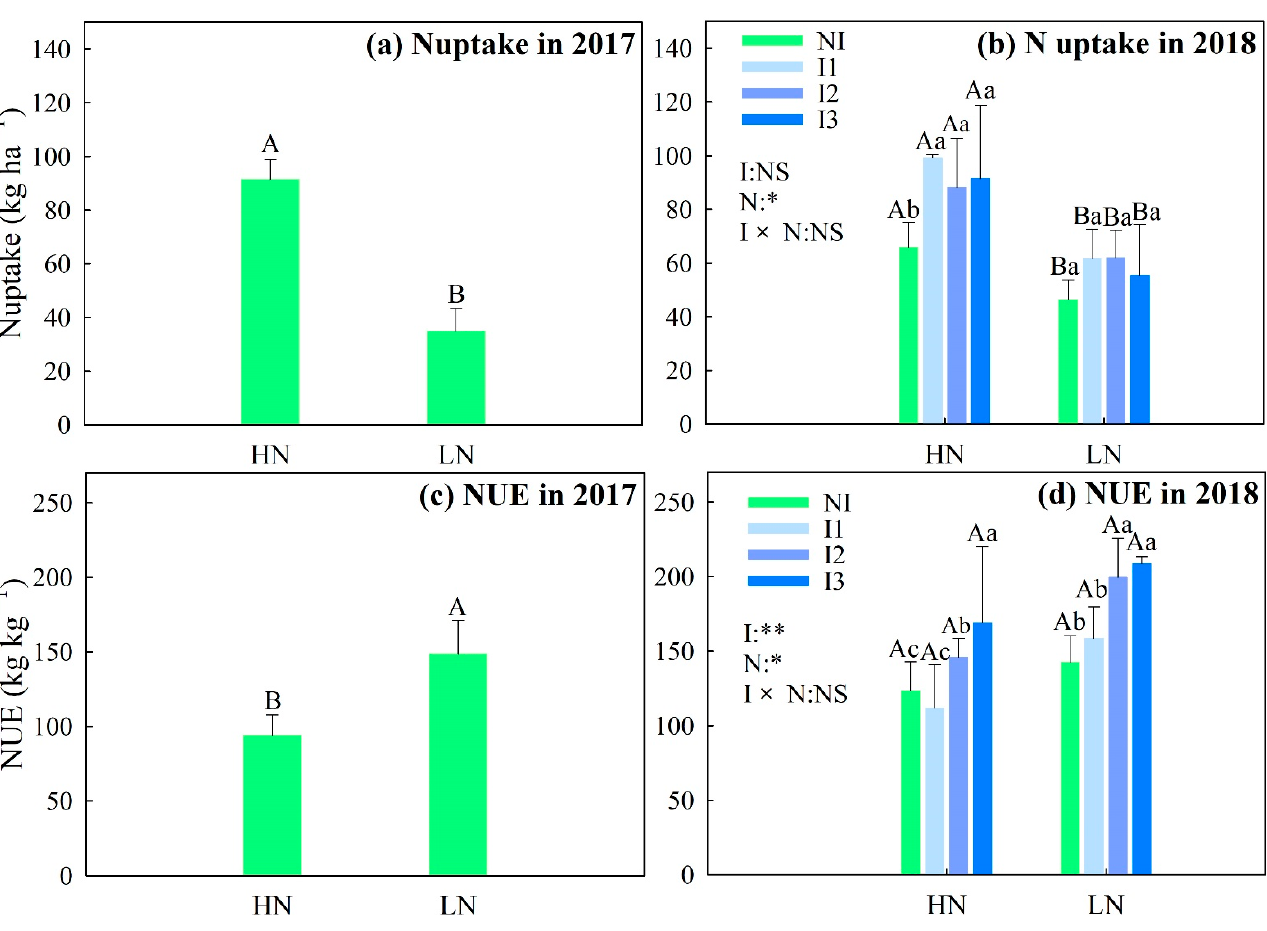
Figure 4. Nitrogen uptake ( a , b ) and nitrogen use efficiency ( c , d ) of oat under different irrigation and nitrogen fertilizer treatments in 2017 ( a , c ) and 2018 ( b , d ). HN—high nitrogen; LN—low nitrogen; NI—no irrigation; I1—irrigation only at flowering; I2—irrigation at tillering and jointing; I3—irrigation at tillering, jointing, and flowering. Different capital letters indicate a significant difference between different nitrogen treatments, and different lowercase letters indicate significant differences among different irrigation treatments under the same nitrogen level ( p < 0.05). I—irrigation;